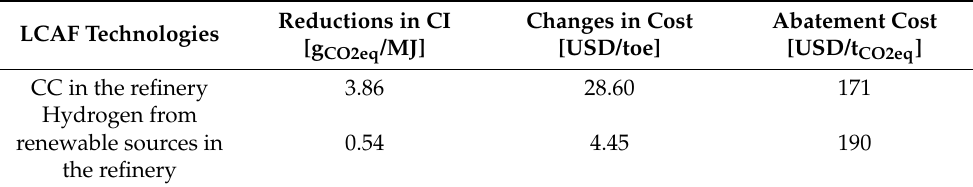
Table 3. Refinery LCAF technologies and practices.